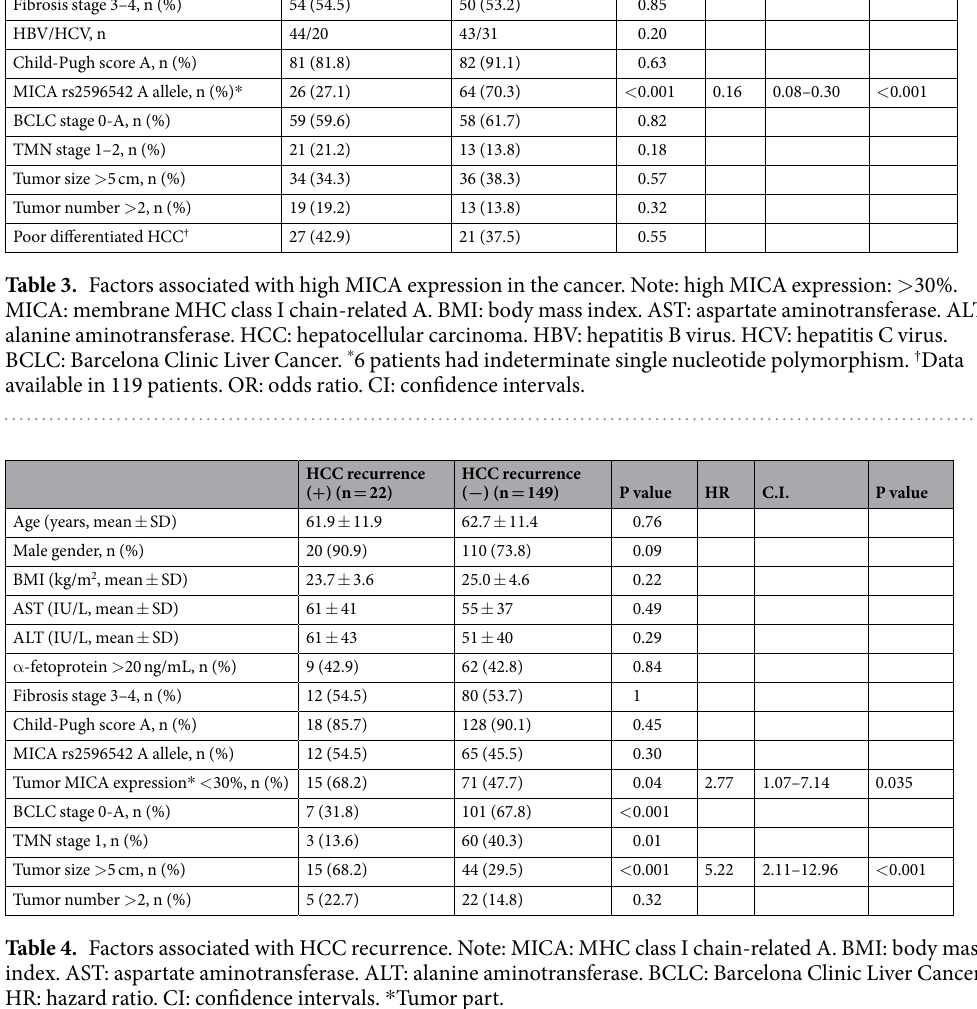
Table 4. Factors associated with HCC recurrence. Note: MICA: MHC class I chain-related A. BMI: body mass index. AST: aspartate aminotransferase. ALT: alanine aminotransferase. BCLC: Barcelona Clinic Liver Cancer. HR: hazard ratio. CI: confidence intervals. * Tumor